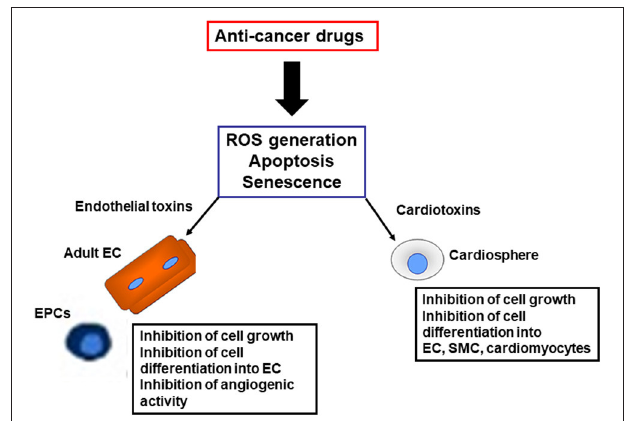
FIGURE 2 | Harmful effects induced by anti-cancer drugs on reparative and regenerative cardiovascular cells. EC, endothelial cells; SMC, smooth muscle cells; EPC, endothelial progenitor cells; ROS, reactive oxygen